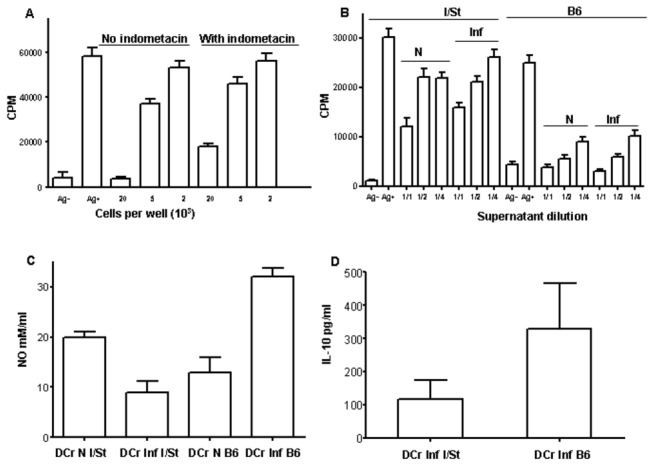
Soluble mediators of DCreg suppressor activity.(A) - B6 DCreg with blocked PGE2 production are less inhibitory compared to control cells (25-40% decrease in inhibition depending on the content of DCreg in culture, P<0.05, ANOVA), but still retain suppressor activity. (B) - Both B6 and I/St cell-free supernatants possessed inhibitory activity regarding T cell proliferation, but in I/St this activity is weaker (P<0.01, ANOVA). (C) - NO production: similar nitrite levels in B6 and I/St co-cultures with lung stroma from naïve mice and opposite shifts in the presence of infected stroma – slight decrease in I/St, but 2-fold increase in B6 cultures, resulting in 3-fold (P<0.01, ANOVA) differences. (D) - The content of IL-10 is significantly (P=0.04, Student’s t-test) higher in B6 compared to I/St supernatants developed on infected stroma. Mean triplicate CFU counts ± SD from 3 independent experiments are displayed.